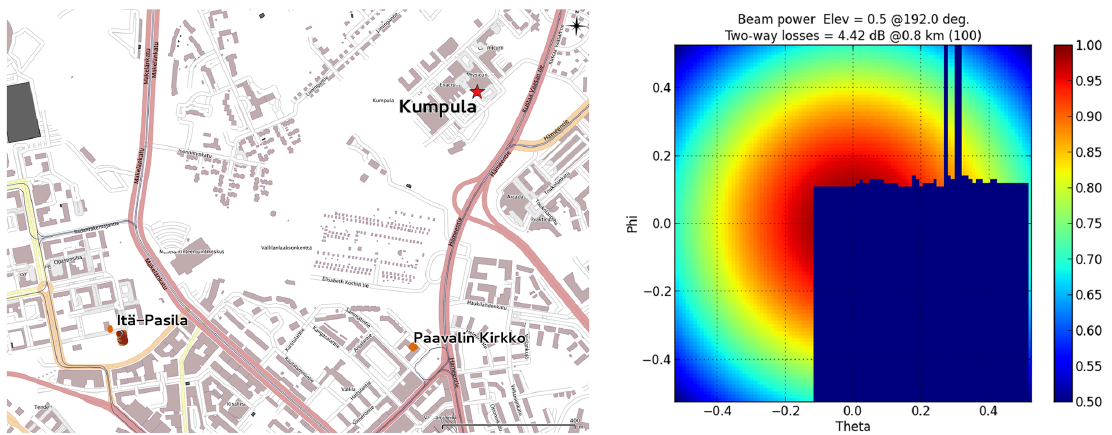
Figure 5. Left: the Kumpula radar and the bell tower map, Helsinki. Right: estimated radar beam blocking at 0.7 ◦ elevation and 192 ◦ azimuth. Color represents the beam power normalized to one in the beam